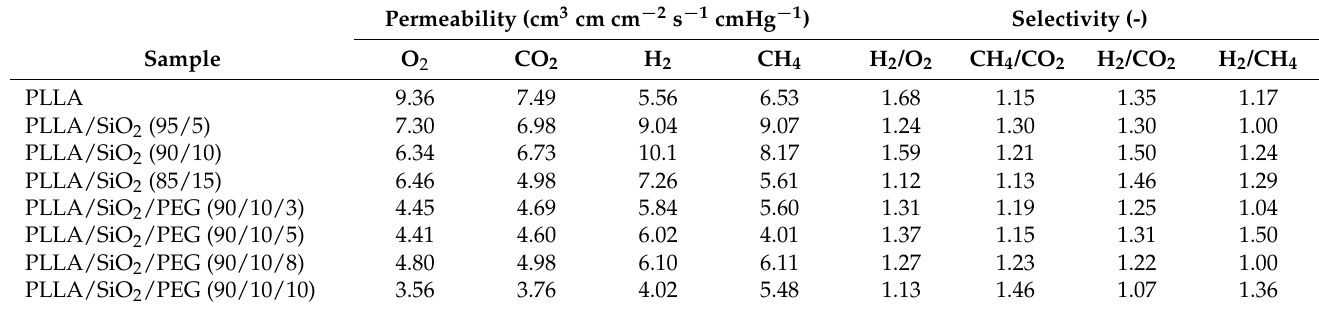
Table 11. Permeability of O 2 , CO 2 , H 2 , and CH 4 in PLLA, PLLA/SiO 2 , and PLLA/SiO 2